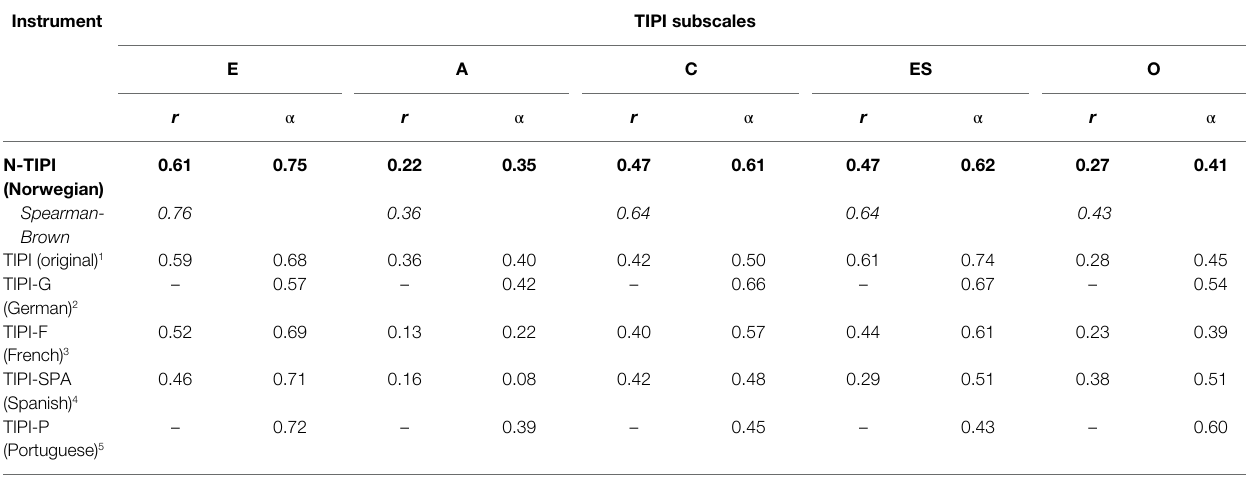
TABLE 6 | Internal consistency (correlations, alpha coefficients, and Spearman-Brown coefficients) for the TIPI subscales, N-TIPI compared with the original TIPI and four other versions.